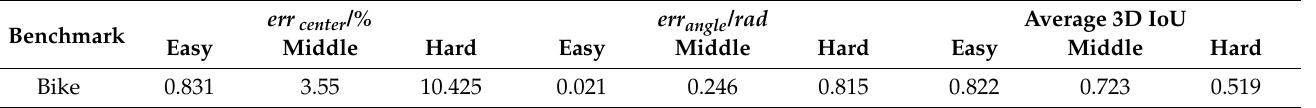
Table 10. Localization error statistics for bikes.